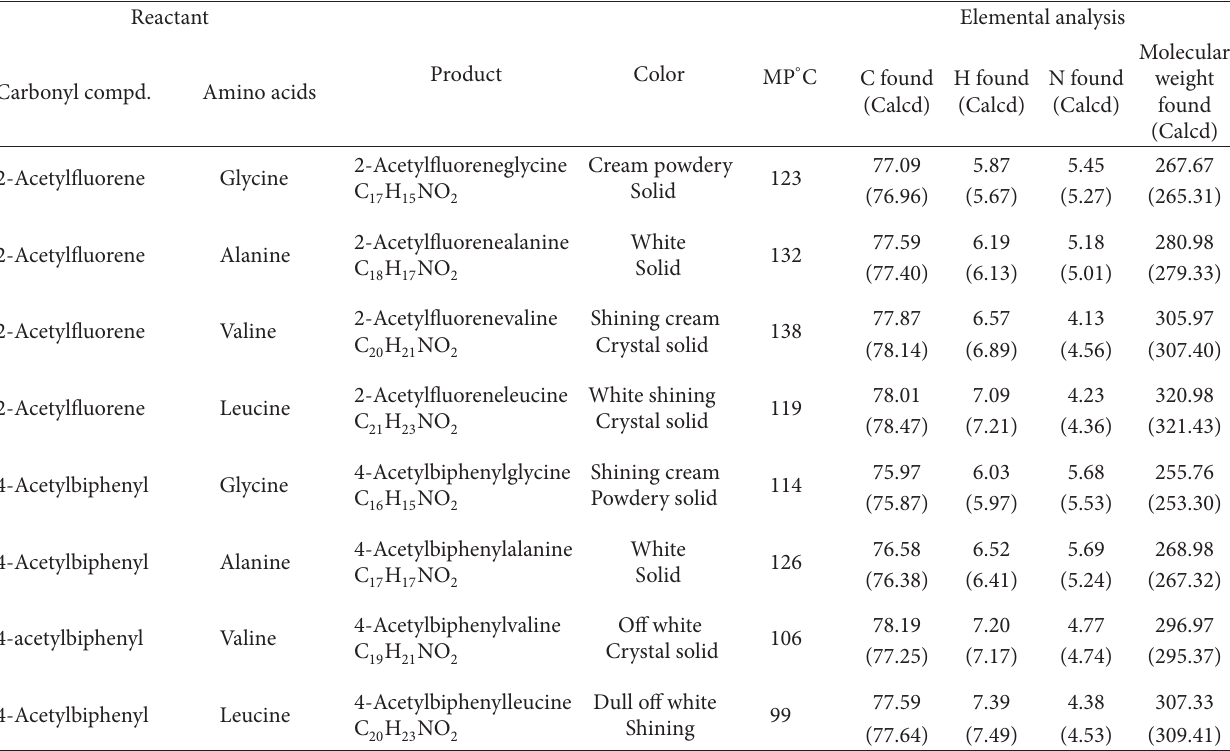
T 1: Analytical and physical data of the ligands.